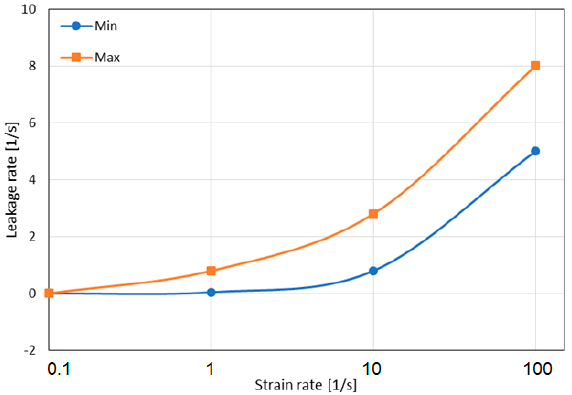
Figure 12. Leakage rate vs. strain rate for 1/8-5052-0.001 (based on [25]).